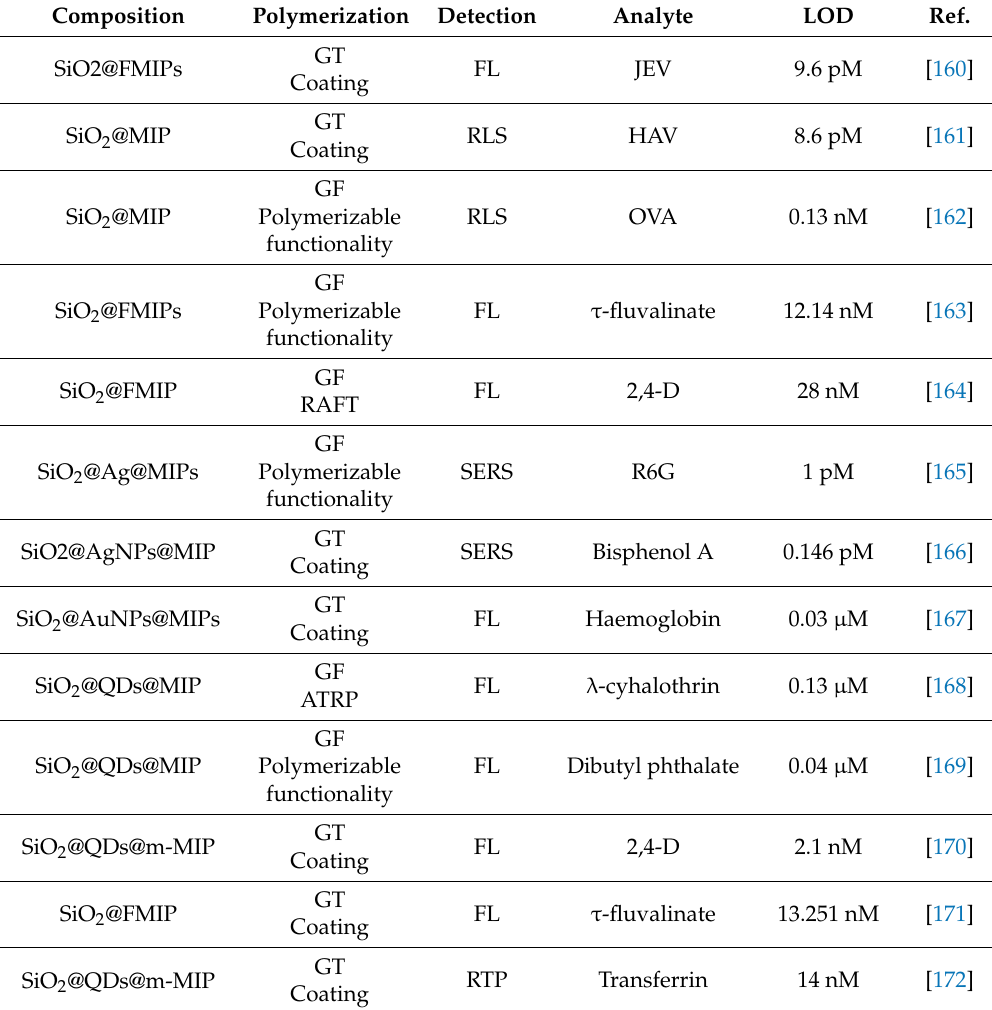
Table 9. Optical sensors based on MIPs deposited on a silica